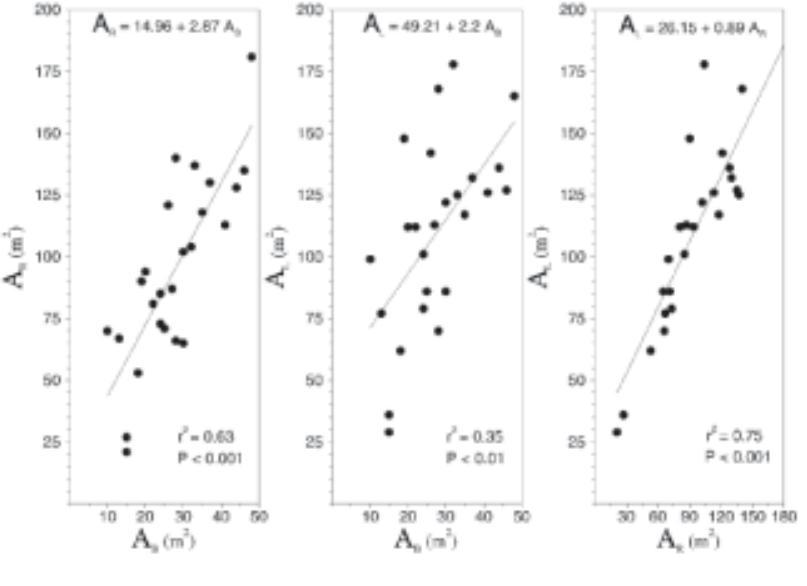
Fig. 3. Regression between the areas of Brokaw (A ), B ) and real gap Runkle (A R area affected by light en- hancement (A ). A and A L R L are the closest together. Data from a beech forest (Zoniën- woud) south of Brussels.